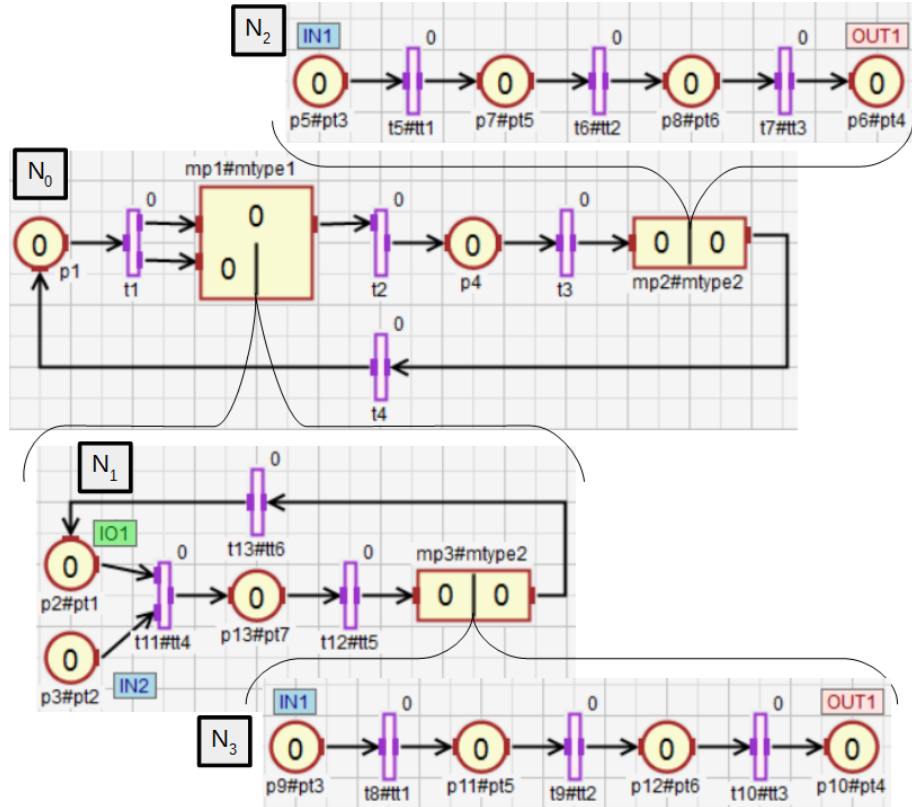
Figure 8. The net with three macroplaces, two of which are of the same type.